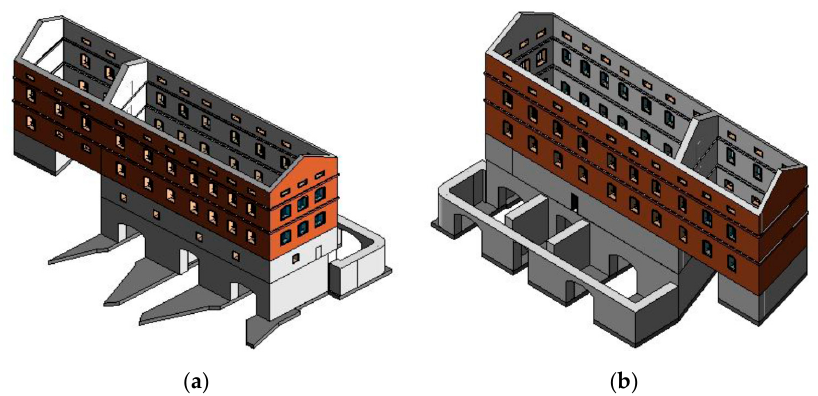
Figure 7. BIM model of the body of the factory: third phase, demolition stage. ( a ): Front view; ( b ) Rear view.